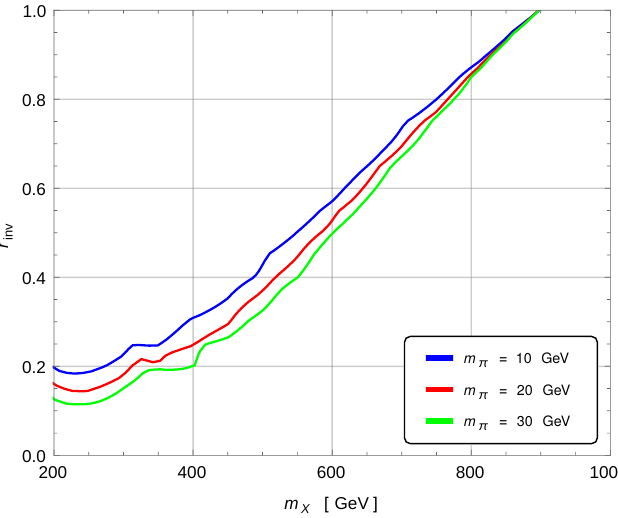
Figure 11. Bounds at 95% CLs on X F for di(cid:11)erent dark pion masses for large r inv . Bounds are L obtained by recasting the slepton search of ref. [46] and assuming the mediator communicates only with the (cid:12)rst generation. The Hidden Valley group G is taken to be SU(3). The excluded regions are left of the